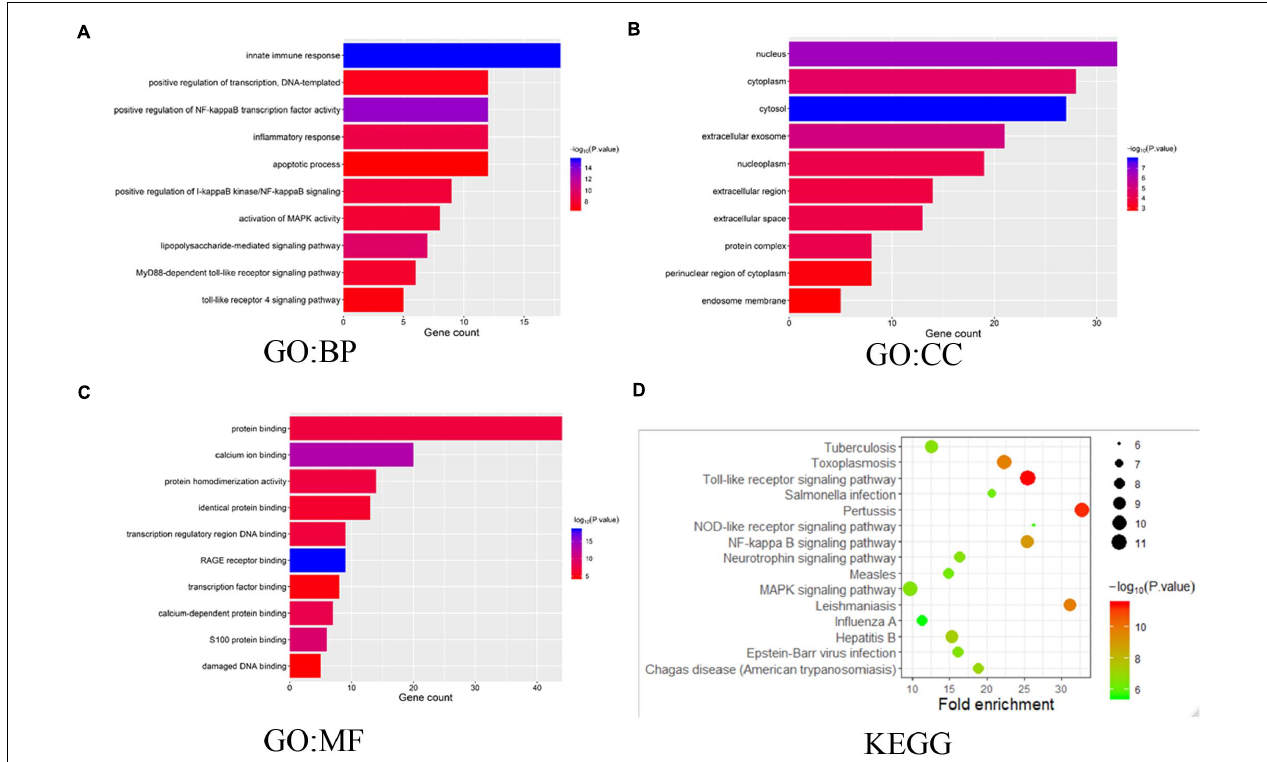
FIGURE 7 | The functions of S100s and genes significantly associated with S100s alterations. GO functional enrichment analysis predicted three main functions of S100s mutations and their 50 frequently altered neighbor genes, including biological process, cellular components and molecular functions (A–C) . KEGG pathway analysis on S100s and their 50 most frequently altered neighbor genes was shown at (D)